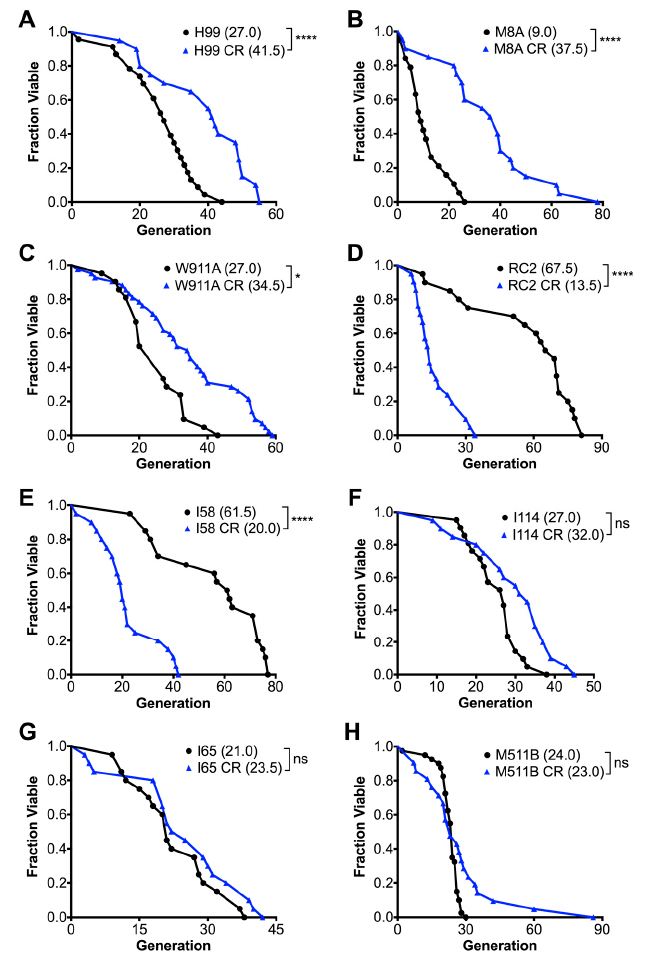
Figure 1. A variable replicative lifespan (RLS) was observed for clinical C. neoformans strains grown in calorie restricted (CR) media. Strains grown in CR media were subjected to 0.05% glucose compared to 2% glucose. CR significantly extended the median RLS of ( A ) strain H99 by 54%; ( B ) strain M8A by 317%; and ( C ) strain W911A by 28%. CR significantly shortened the median RLS of ( D ) strain RC2 by 80%, and ( E ) strain I58 by 67%. CR did not significantly affect the median RLS of strains ( F ) I114, ( G ) I65, and ( H ) M511B. Experiments were performed in duplicates with the respective medium ( n = 20–40 cells). p- values were calculated by Wilcoxon Rank Sum test (* p < 0.05, **** p < 0.0001, ns not significant).